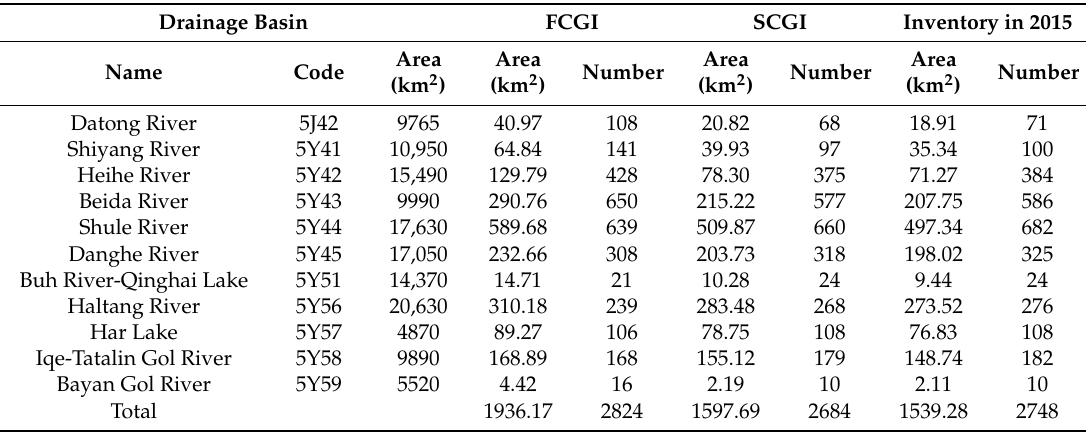
Table 2. Glacier distributions in different drainage basins from three